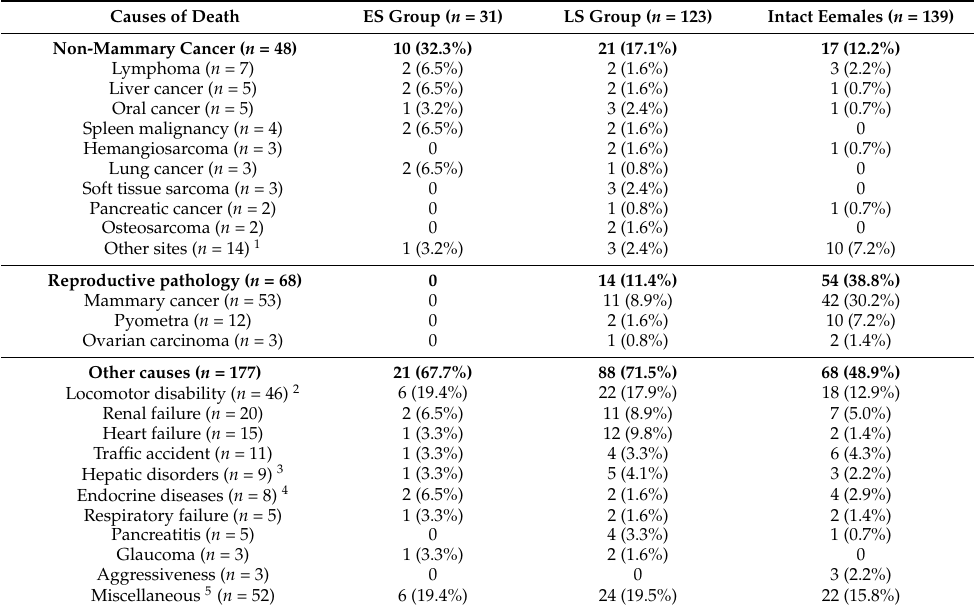
Table 2. Causes of death of female dogs followed-up until death (N s = 293) according to their sterilization